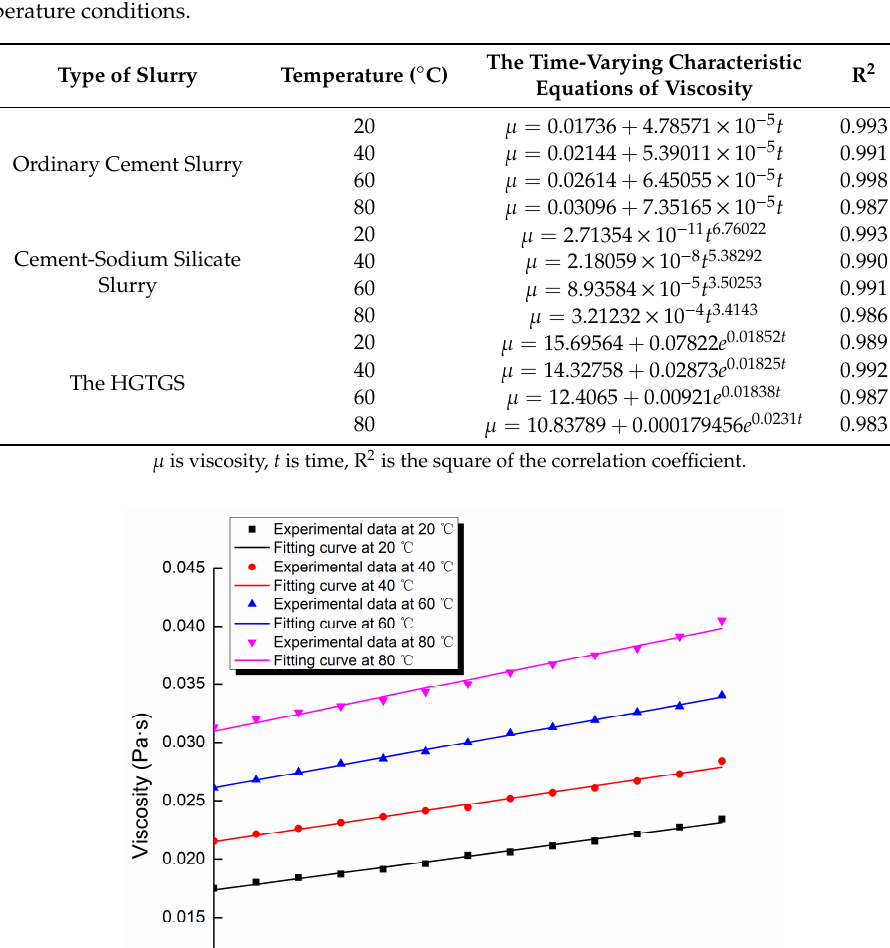
Table 6. The time-varying characteristic equations of viscosity of three kinds of slurries in different temperature conditions.